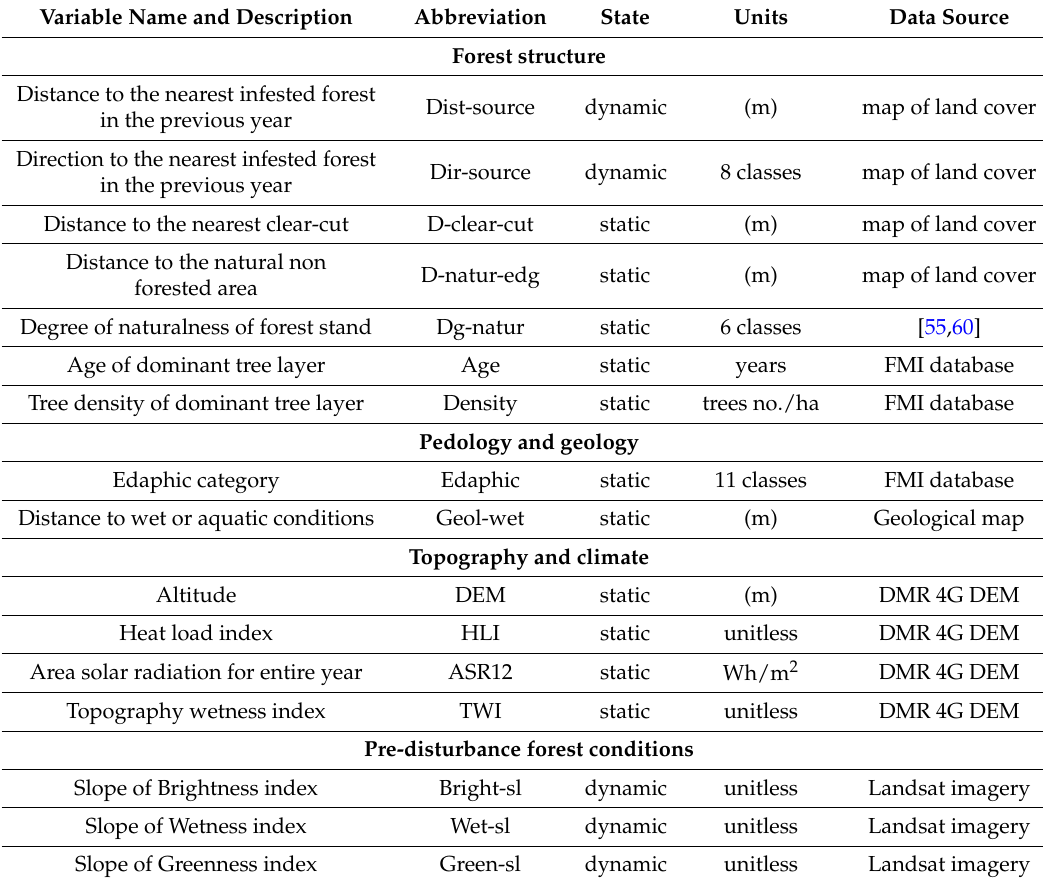
Table 2. List of predictors for bark beetle infestation including pre-disturbance indices describing forest susceptibility and predictors of bark beetle